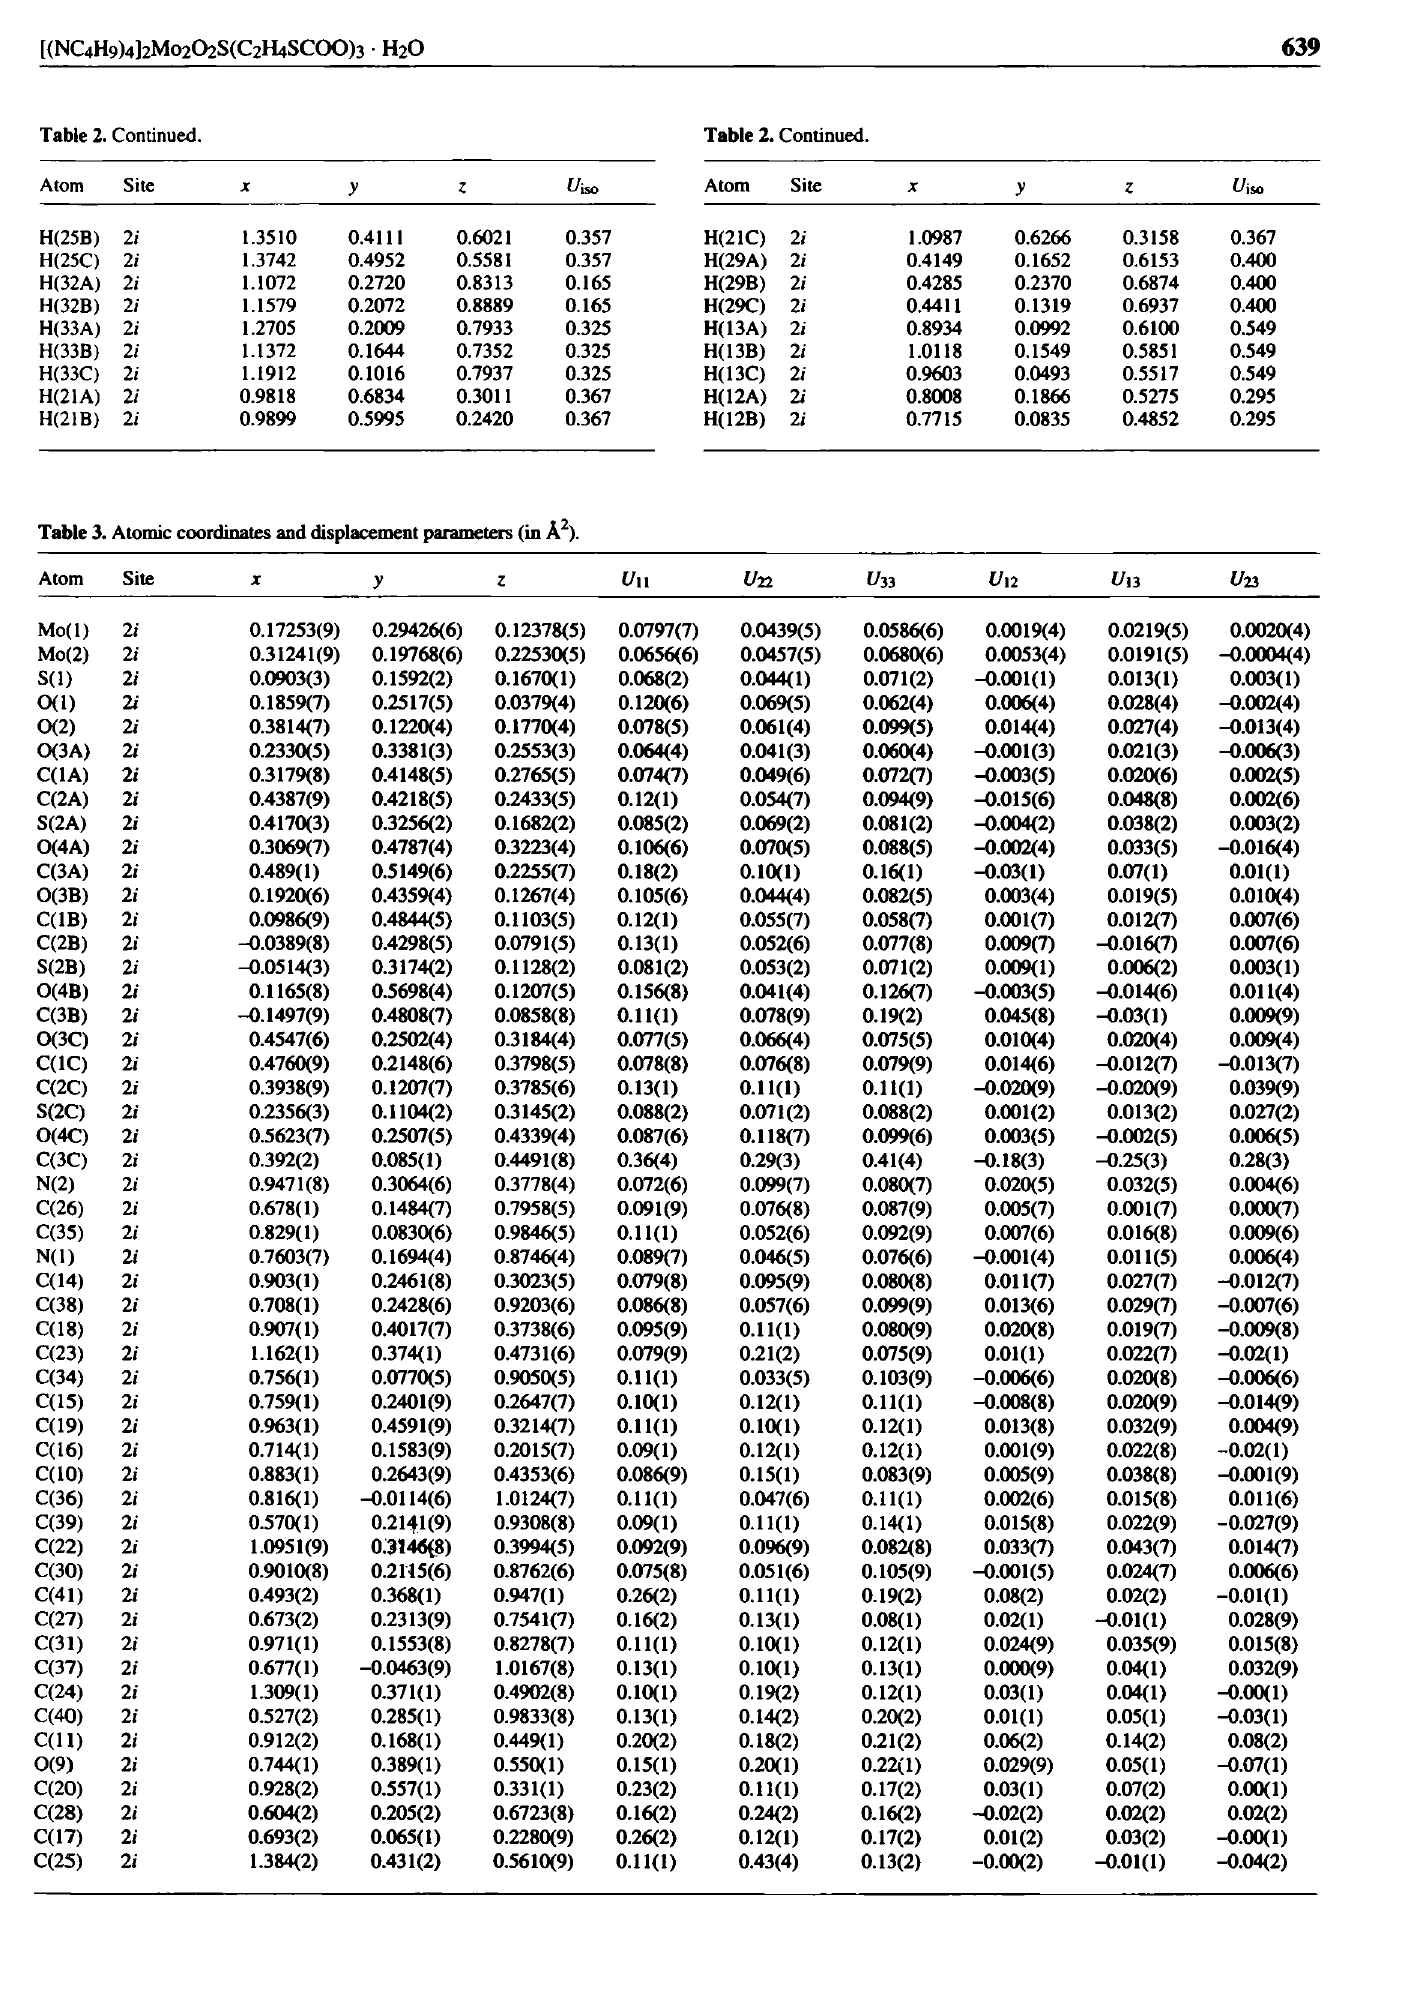
Table 3. Atomic coordinates and displacement parameters (in A 2